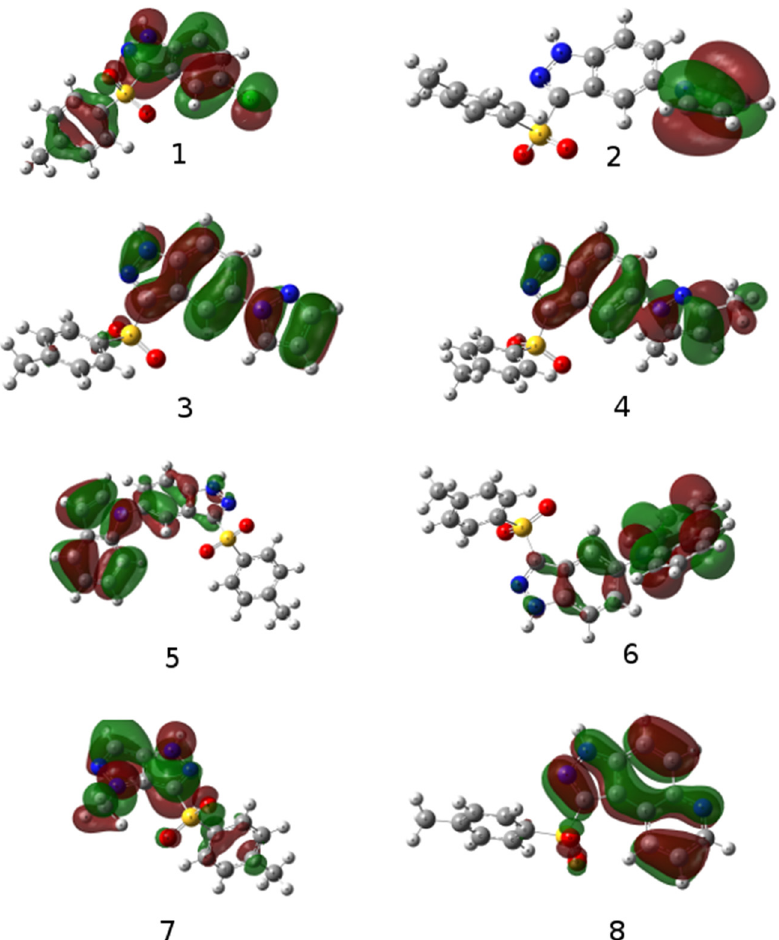
Figure 3: The HOMOs generated for compounds 1 – 8 optimised at the B3LYP/6 - 31G ( d,p ) level of theory in the gaseous phase; vertical excited states were calculated at the B3LYP/6 - 311 ++ G ( 2d,3p ) level of theory in vacuo